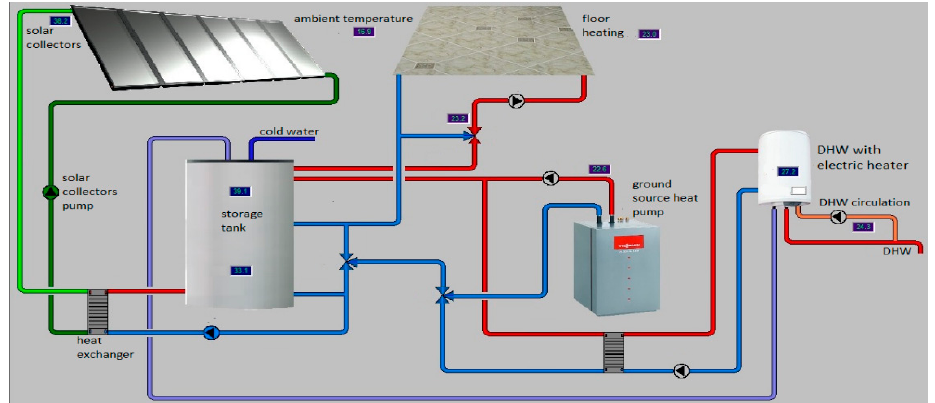
Figure 8. The print screen displaying the configuration and operation of the ground heat pump system coupled with solar heating system.